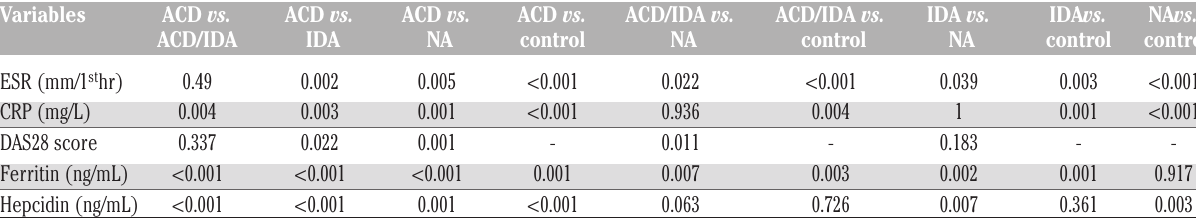
Table 4. Comparison of acute inflammatory markers and DAS 28 score in 51 RA patients (P values).